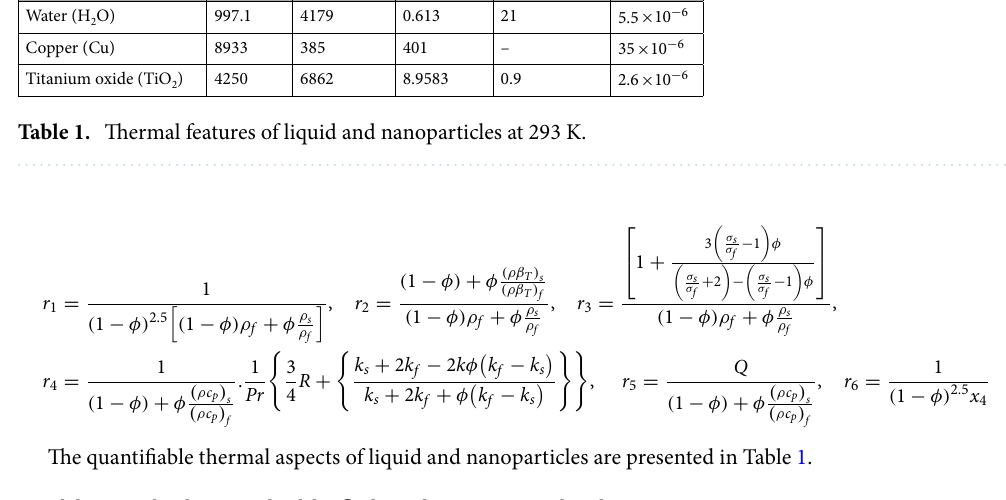
Table 1. Thermal features of liquid and nanoparticles at 293 K.